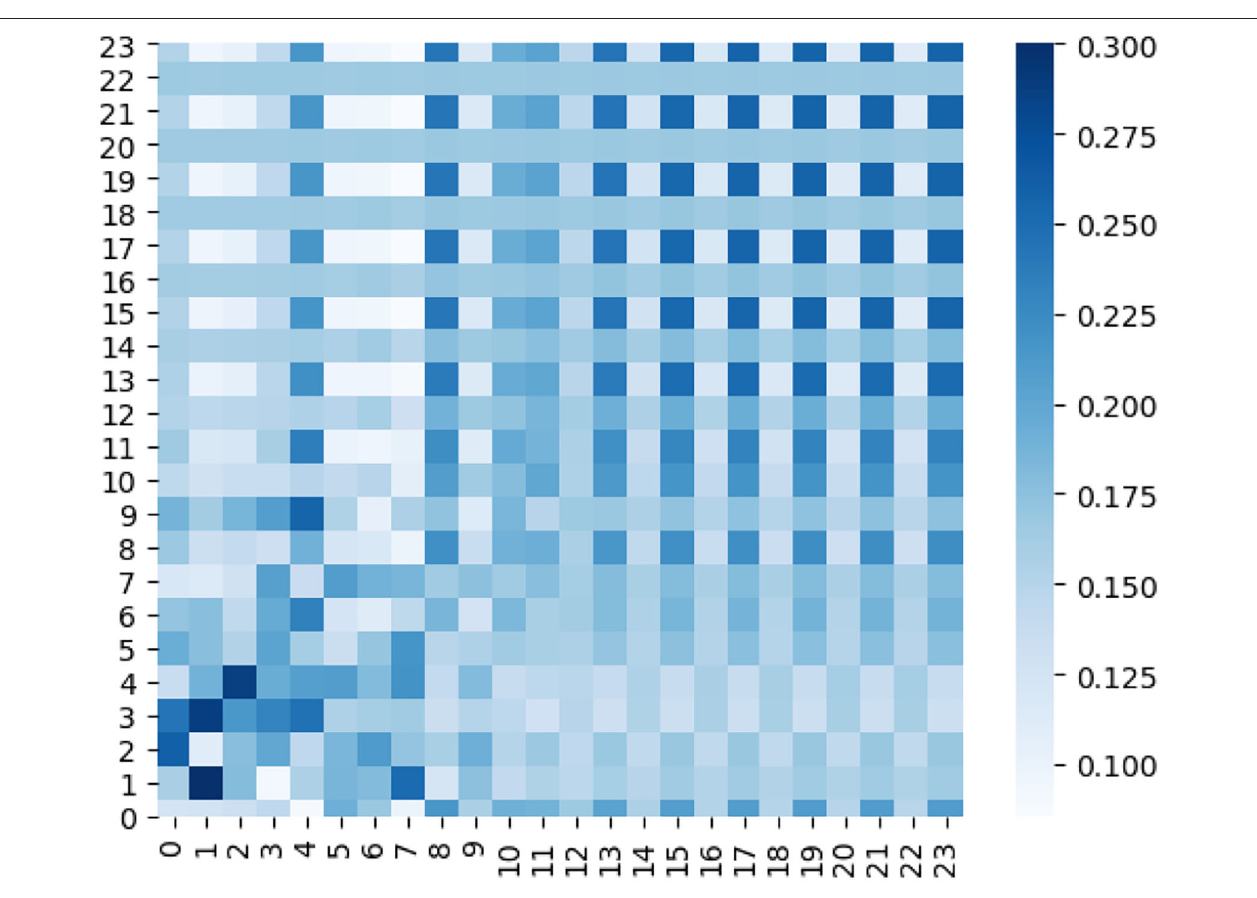
FIGURE 10 | Temporal ensemble attention coefficients of a certain sensor are visualized as a heat